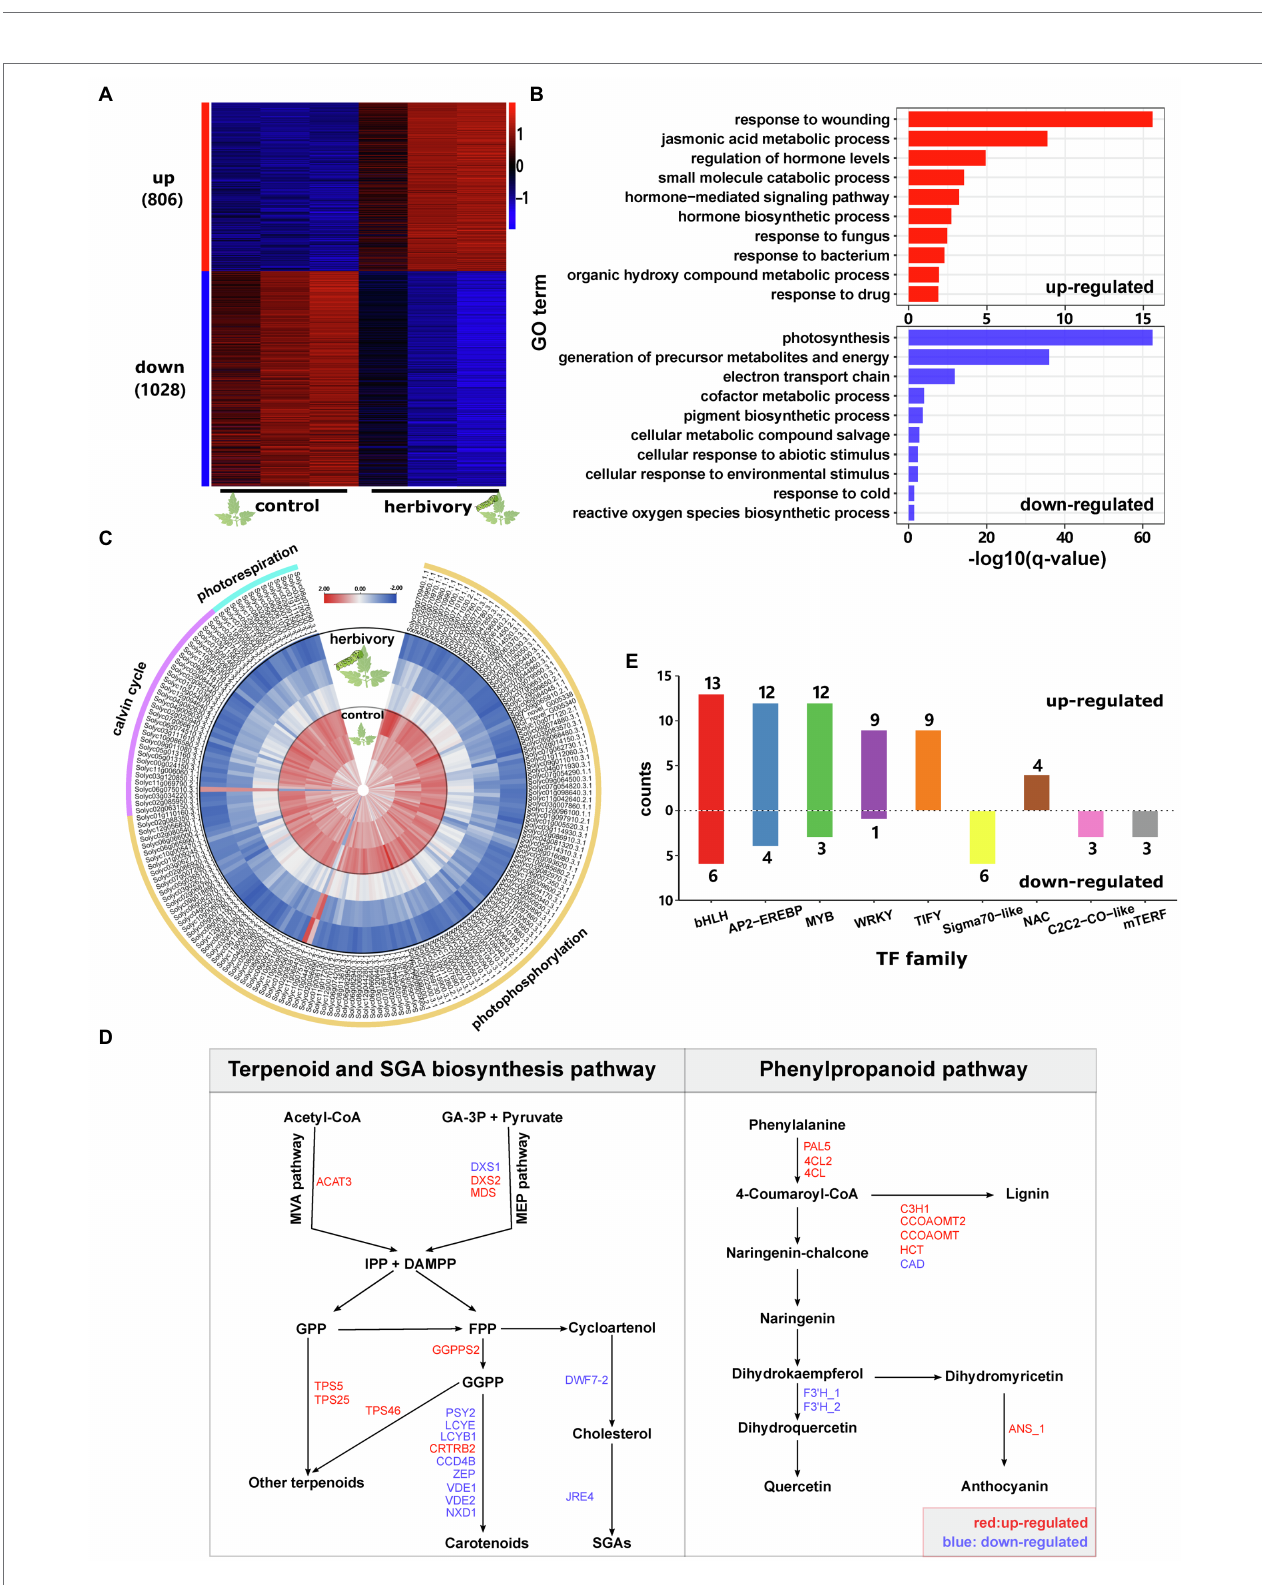
FIGURE 1 | Herbivory-induced transcriptome changes in tomato leaves. (A) Heat map showing the expression patterns of herbivory-responsive genes in domesticated tomato. ‘up’ means upregulated by herbivory, and ‘down’ means downregulated by herbivory. The numbers in brackets are the corresponding gene numbers. ‘control’ and ‘herbivory’ represent control leaves and herbivore-infested leaves, respectively. Each treatment had three biological replicates.